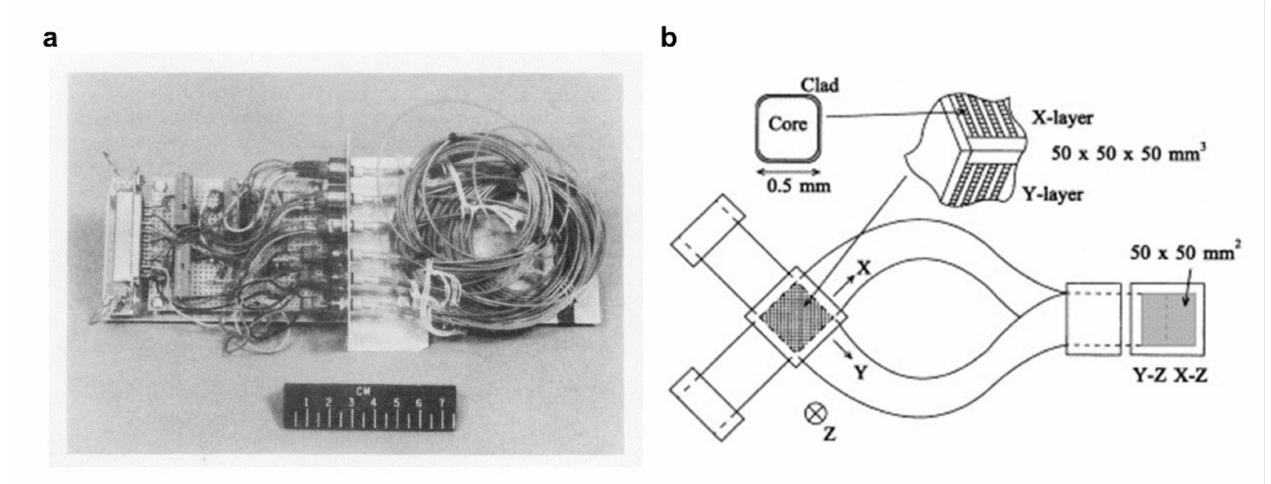
Figure 11. The optical fiber radiation dosimeter for radiation monitoring in space. ( a ) Testbed with sensing fibers for NST-2 mission. Reprinted with permissions from ref. [145]. Copyright 1969, IEEE. ( b ) Structure of a scintillating fiber stack. Reprinted with permissions from ref. [147]. Copyright 2001, Elsevier Science